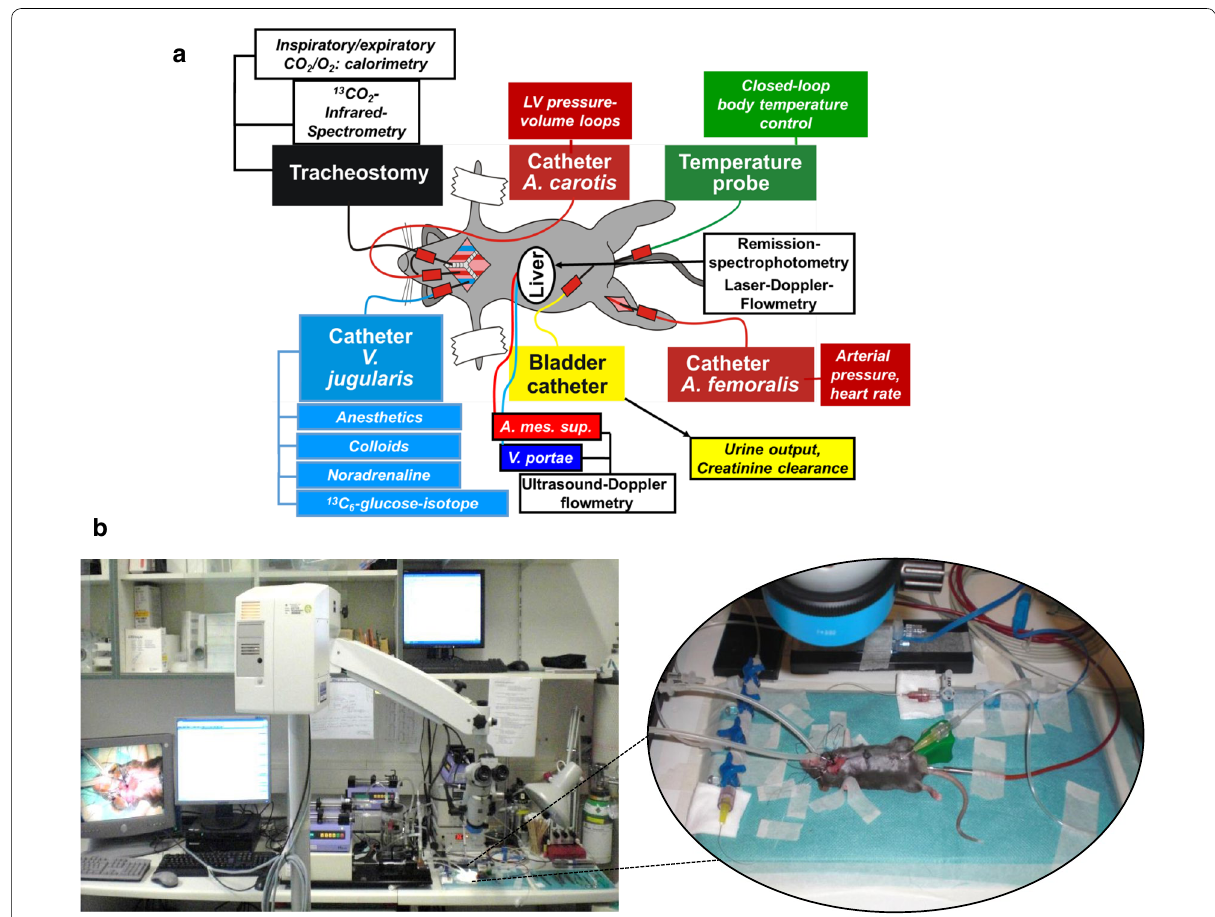
Fig. 3 ICU environment in murine experiments. a Schematic representation of the monitored parameters; b representative illustration of miniaturization of sophisticated equipment used to reproduce the ICU environment in murine experiments; A. carotis, artery carotis; A. mes. sup., artery mesenteric superior; v. portae, vein portae; A. femoralis, artery